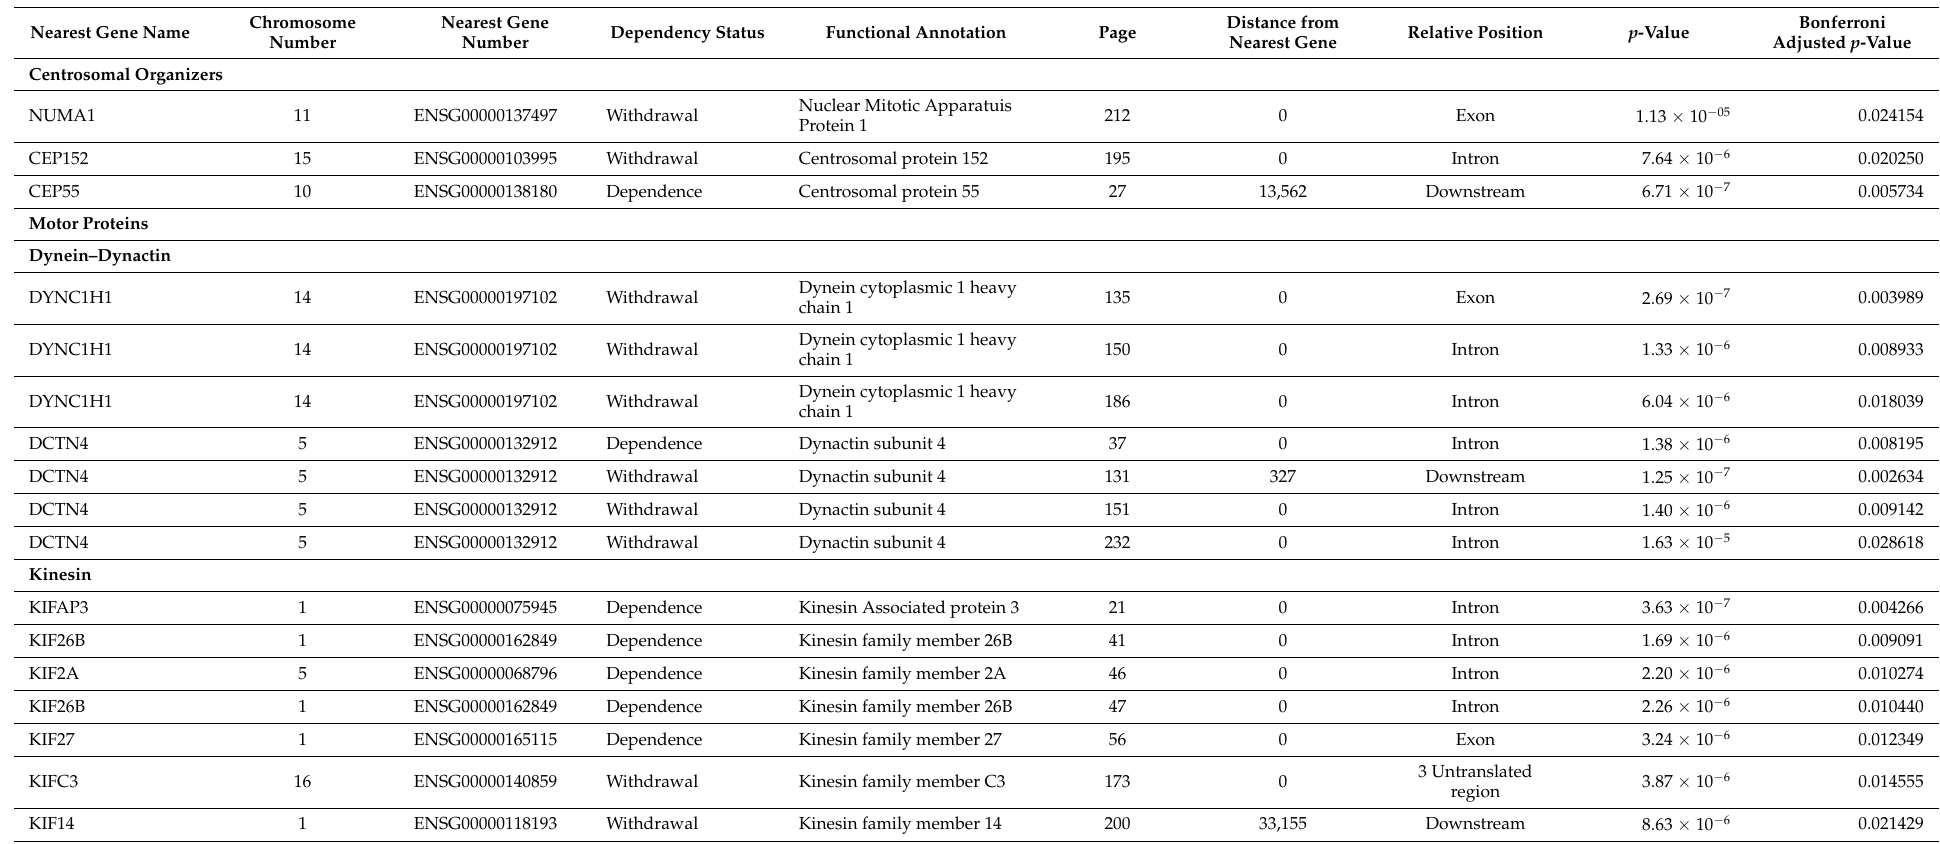
Table 9. EWAS Hits on Major Centromere Proteins; Data from Schrott